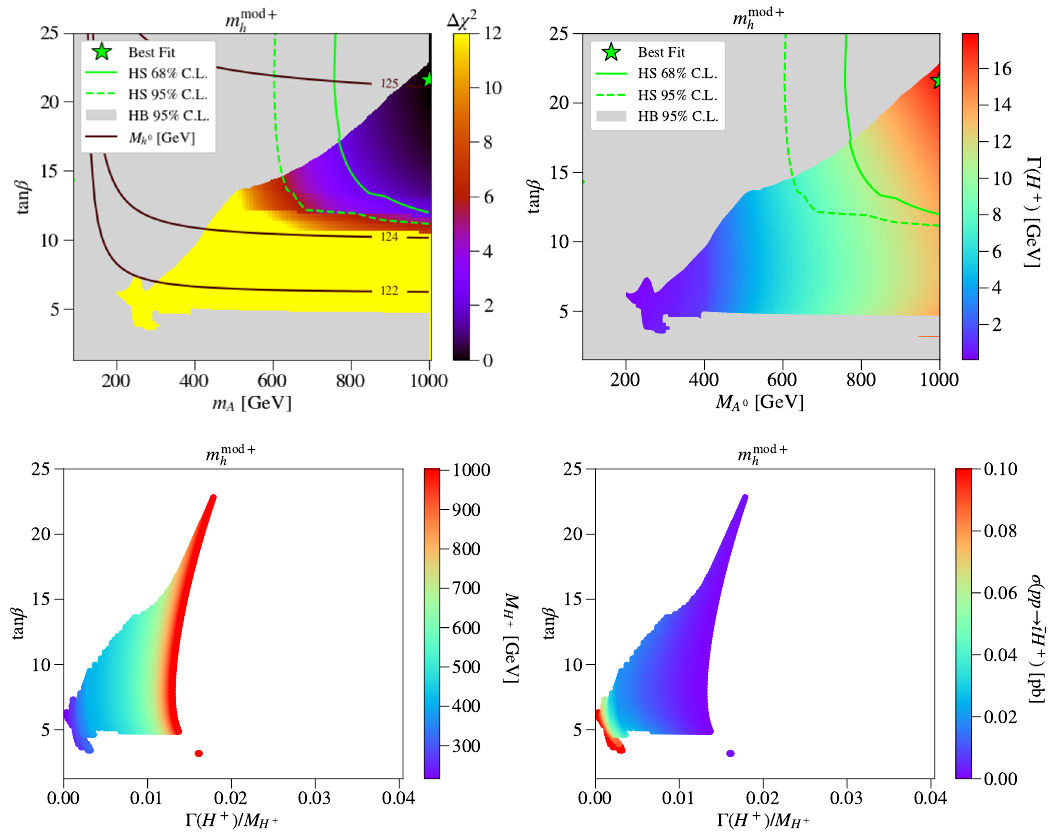
Figure 3 . Allowed parameter region in the m mod+ scenario over the ( m A (cid:17) M , tan (cid:12) ) plane A 0 h with colour showing (cid:1) (cid:31) 2 (top-left) and the charged Higgs boson mass (top-right). The LHC Higgs searches constraints are included. The light green contours are HiggsSignals exclusion limits at 1 (cid:27) (solid) and 2 (cid:27) (dashed). The light gray area is excluded by HiggsBounds at 2 (cid:27) . The solid brown lines are contours for the lighter CP-even scalar h 0 mass. The best (cid:12)t point is located at M (cid:25) 1 TeV and tan (cid:12) = 20. In the two bottom panels of (cid:12)gure 3 we present tan (cid:12) as a function H (cid:6) of (cid:0) =M with the colour code showing the charged Higgs mass (left) and the charged Higgs H (cid:6) H (cid:6) production cross section